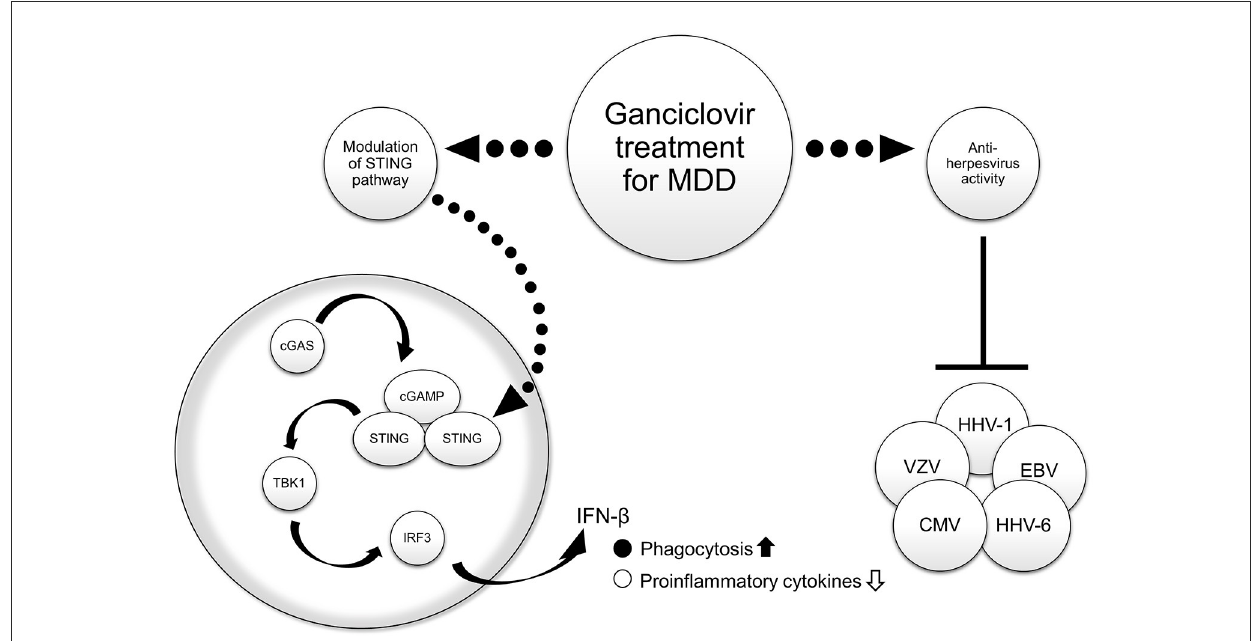
FIGURE1 Hypothesized mechanisms of the therapeutic effect of ganciclovir in major depressive disorder (MDD). The right side of the figure shows antiviral activity, and the left side shows that activation of the STING pathway in central nervous system cells leads to the suppression of neuroinflammation by promoting phagocytosis and inhibiting inflammatory cytokine production. Source: Figure made by the authors with reference to Poole et al. (38) and Duan et al. (44). cGAS, cyclic guanosine monophosphate (GMP)-adenosine monophosphate (AMP) synthase; cGAMP, 2 ′ 3 ′ -cyclic-GMP-AMP; CMV, cytomegalovirus; EBV, Epstein–Barr virus; HHV, human herpesvirus; IFN- β , interferon beta; IRF3, interferon regulatory factor 3; MDD, major depressive disorder; STING, stimulator of interferon genes; TBK1, TANK-binding kinase 1; VZV, varicella-zoster